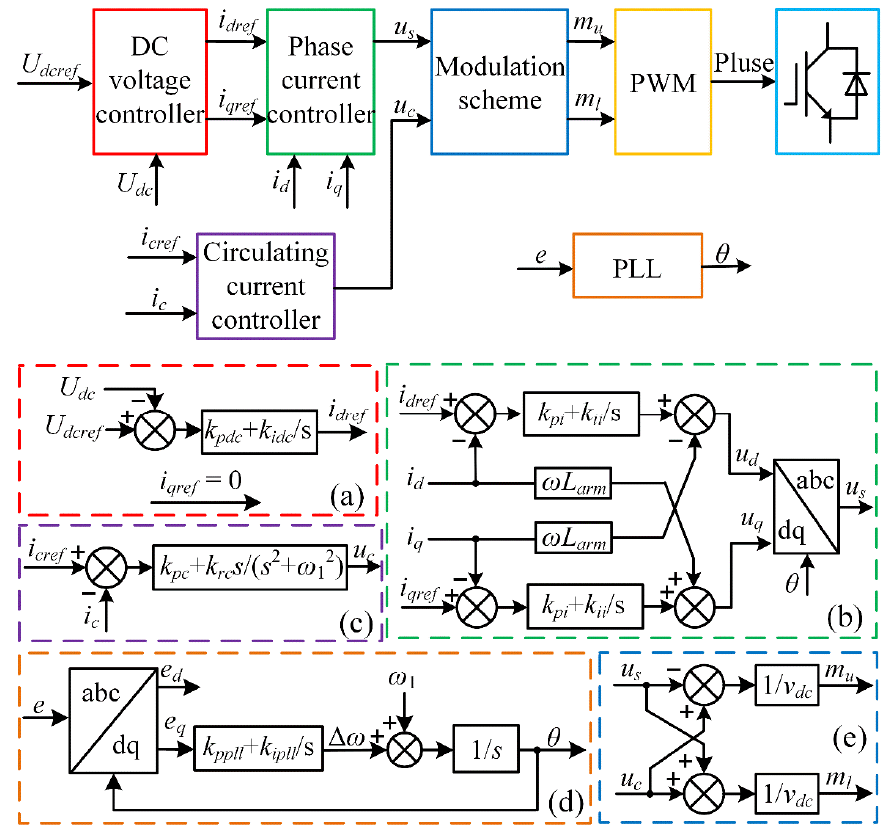
Figure 2. Control scheme of the grid-connected MMC. ( a ) DC-bus voltage control. ( b ) Phase current control. ( c ) Circulating current suppression controller. ( d ) PLL. ( e ) Modulation